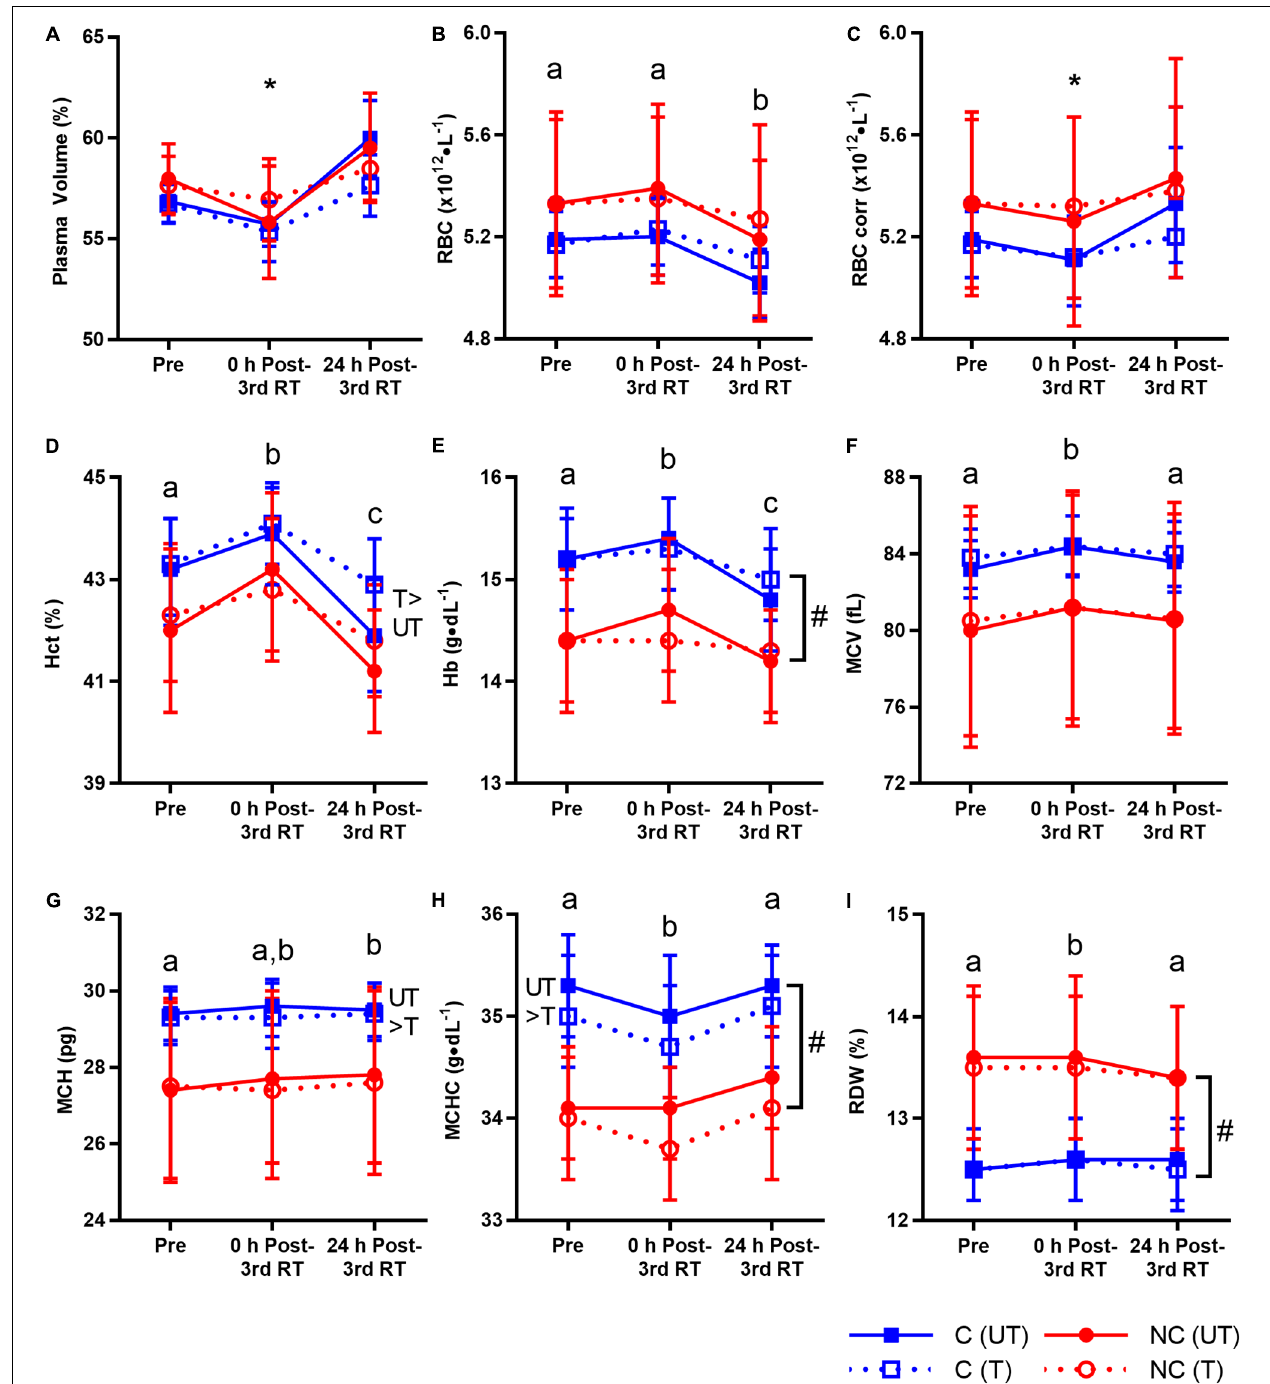
FIGURE 3 | Plasma volume and red blood cell (RBC) parameters before resistance training (RT) at first session (Pre), and 0 and 24 h post-3rd RT session in untrained (UT, solid lines) and trained (T, dotted lines) states for consecutive (C, blue squares) and non-consecutive (NC, red circles) groups: plasma volume (A) , RBC count (B) , RBC count corrected for plasma volume changes (C) , hematocrit (D) , hemoglobin (E) , mean corpuscular volume (F) , mean corpuscular hemoglobin (G) , mean corpuscular hemoglobin concentration (H) , and RBC distribution width (I) . Values are means with 95% confidence interval. No significant interaction for all parameters ( p = 0.076–0.994) except corrected RBC count ( ∗ significant time × training interaction, p = 0.001; details in text). Significant main effect of time for all parameters ( p < 0.001–0.003). Different letters indicate significant difference from other time points ( p < 0.001–0.040). Comparison between UT and T states indicates significant difference between them ( p = 0.001–0.041). # Significant group difference between C and NC ( p = 0.006–0.030).